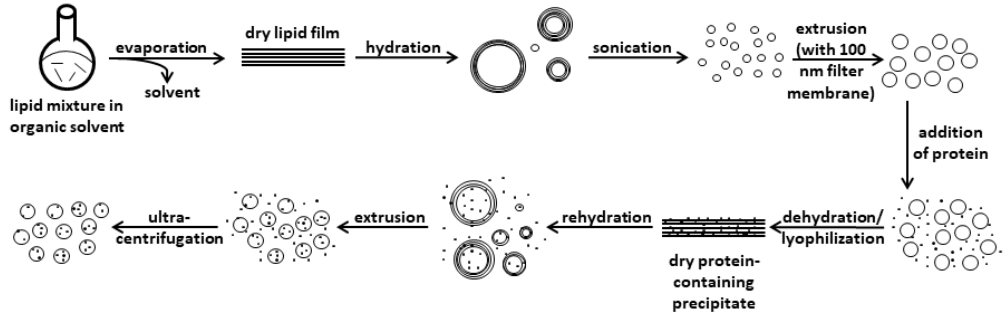
Figure 1. Workflow for synthetic outer membrane vesicle (sOMV) preparation. Depicted is a combined process by which vesicles are homogenized through an extrusion step without proteins, and then the protein is added and the vesicles are dehydrated and rehydrated. The protein-loaded products are again homogenized by extrusion, and excess protein is removed by ultracentrifugation. Adapted from Walde and Ichikawa [30] and modified.